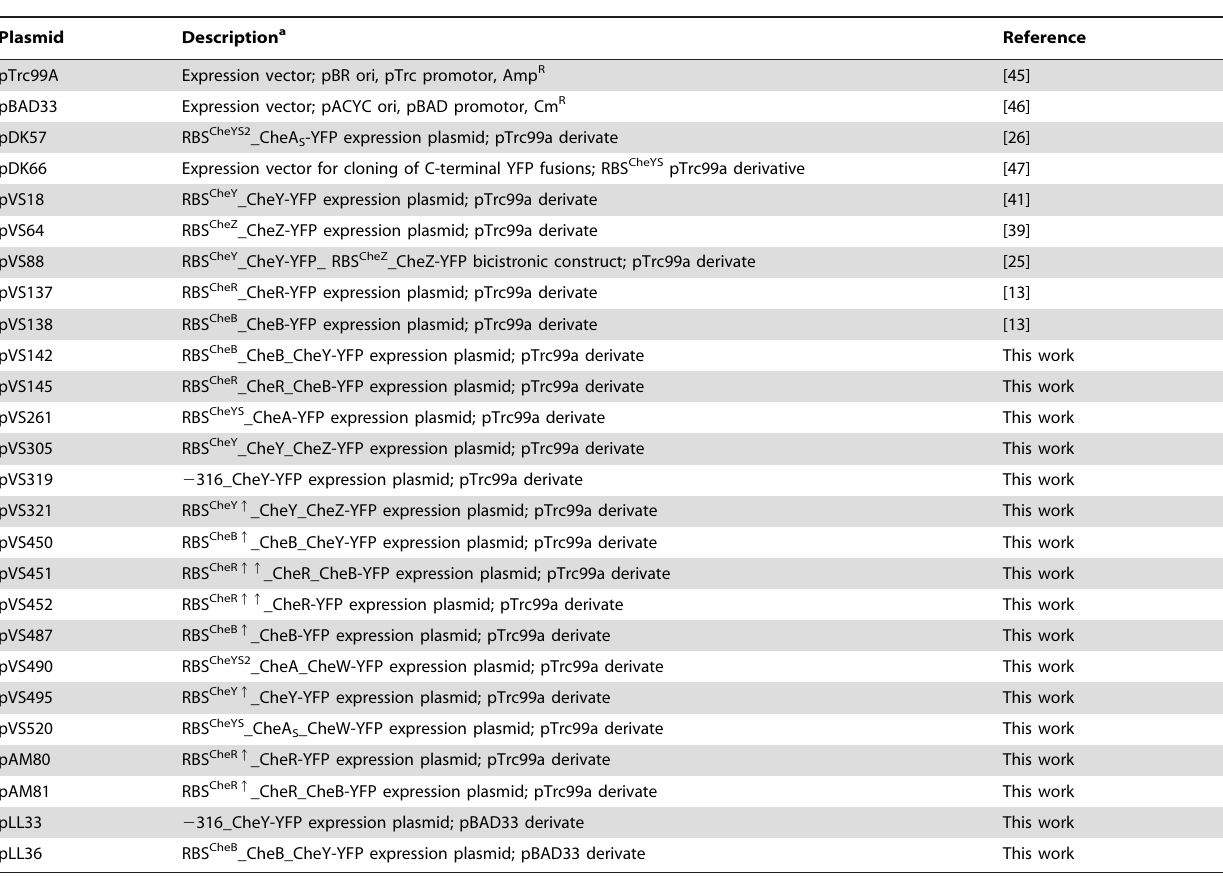
Table 3. Plasmids used in this study.